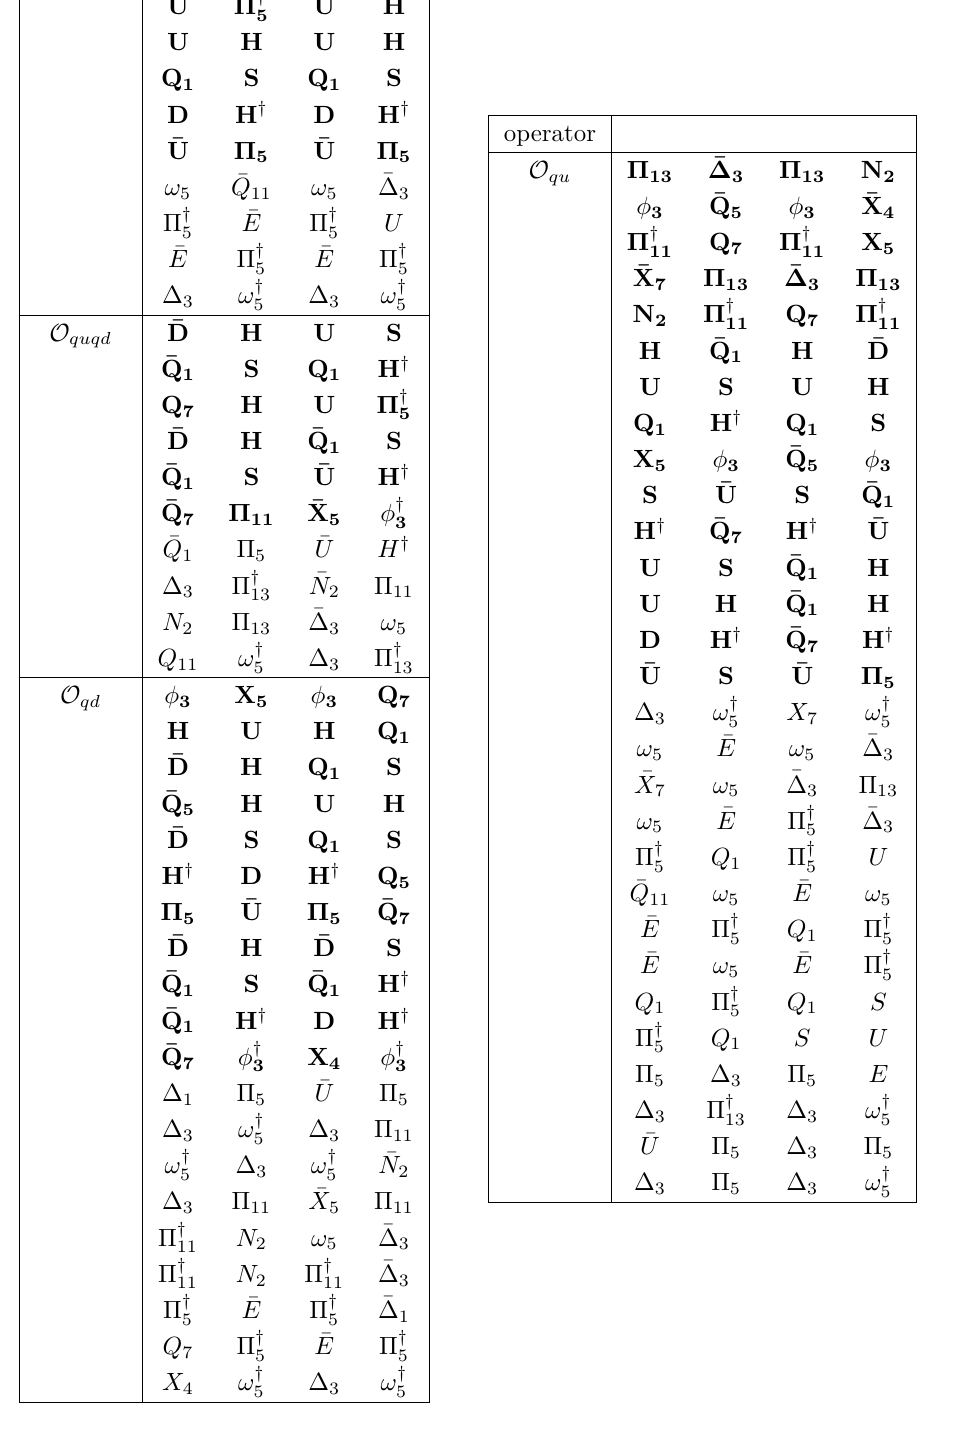
Table 14. Quark specific models, part 1. Boldface models are